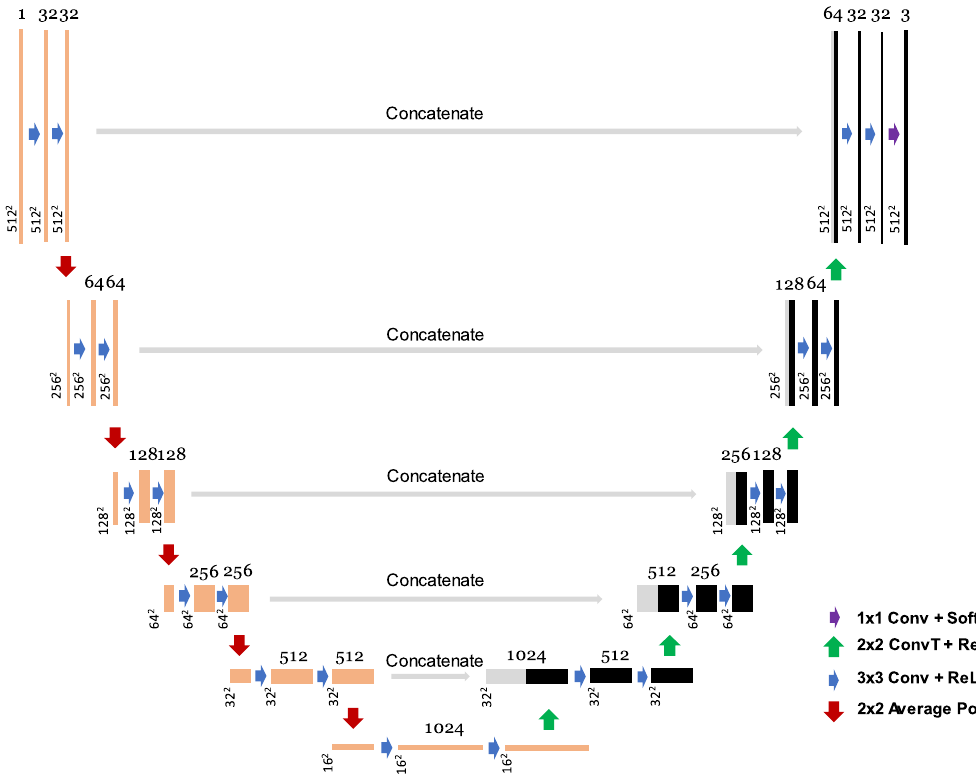
Figure 1. A schematic of the U-Net architecture. The number of feature maps is indicated on the top of each box, and the dimensions of the feature maps are on the bottom left corner. Orange boxes show the contraction path, and black boxes show the expansion path. The gray arrows and boxes indicate the concatenation path at each convolutional